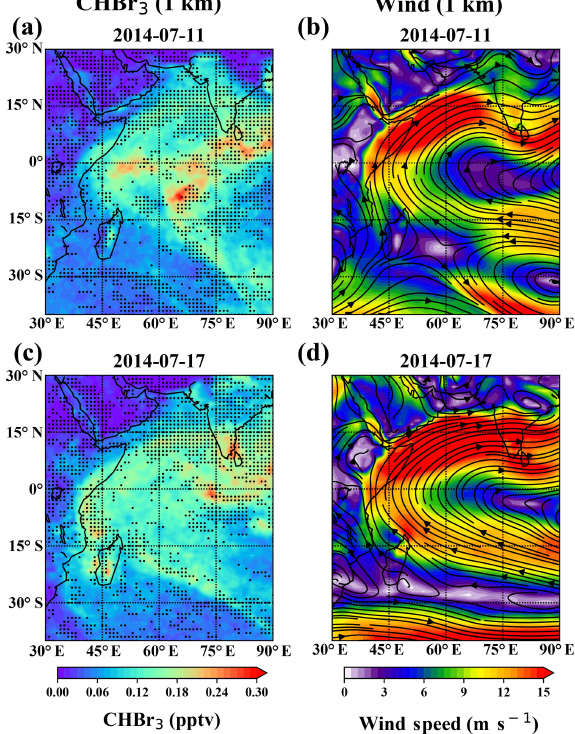
Figure 4. Same as Fig. 2, but for the OASIS